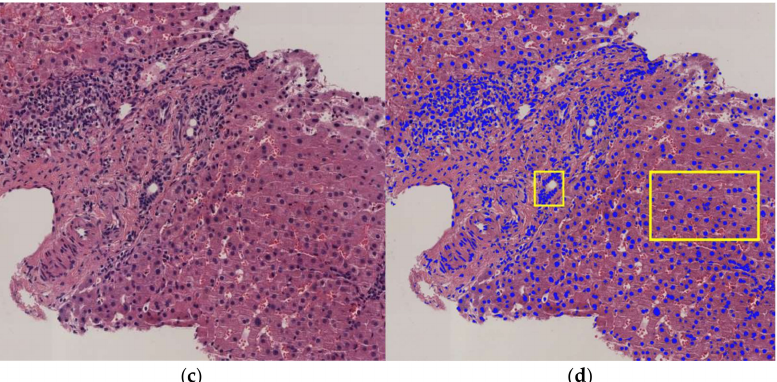
Figure A1. ( a ) The immunohistochemistry for CD45 shows positive reaction to all leucocytes express- ing this membrane marker; ( b ) colour mask segmentation only identifies leucocytes (marked in blue); ( c ) H&E-stained tissue section; ( d ) colour mask segmentation (marked in blue) identifies leucocytes and non-inflammatory cells spaces such as hepatocytes and cholangiocytes nucleus (yellow squares).